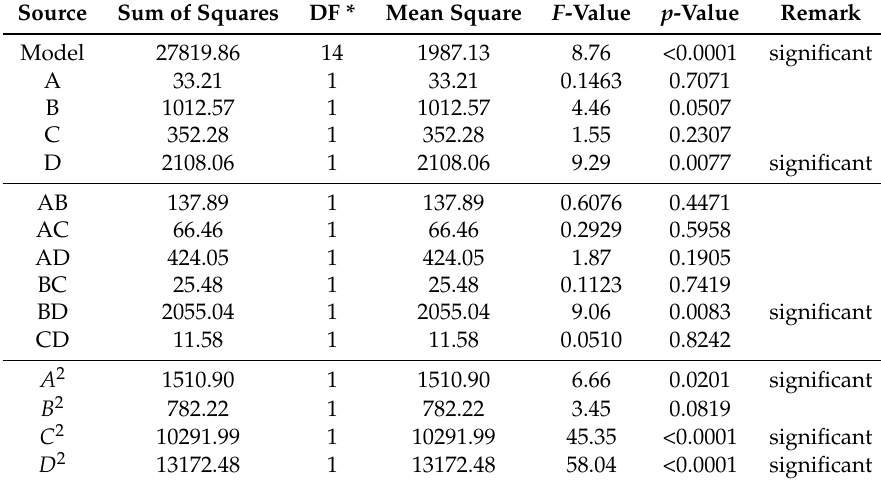
Table 3. ANOVA for the quadratic